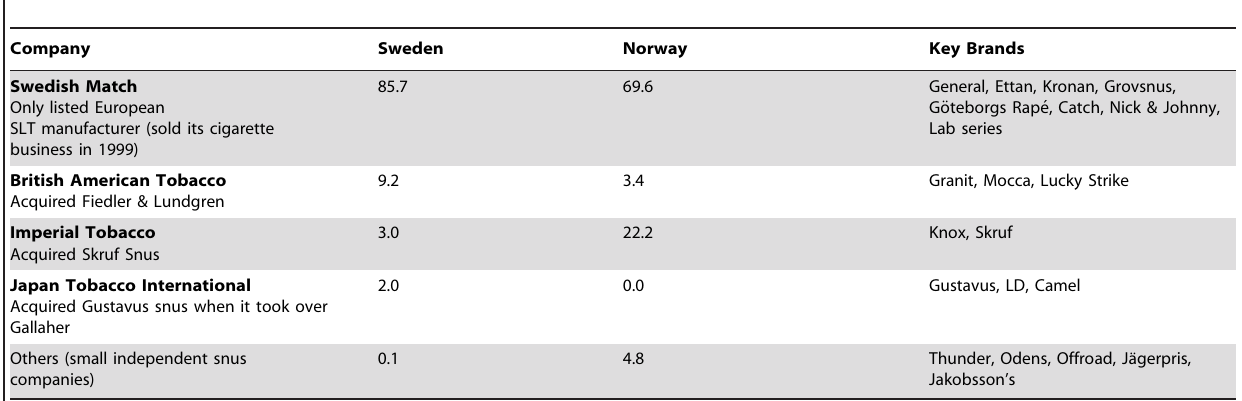
Table 3. Snus company market shares (volume) in Sweden and Norway by percentage, 2011.